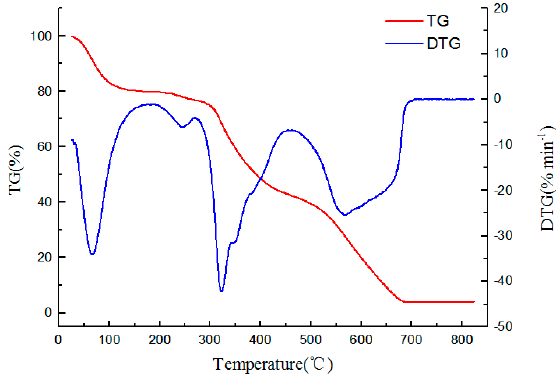
Figure 4. TGA and DTG analyses of the IL polymer.